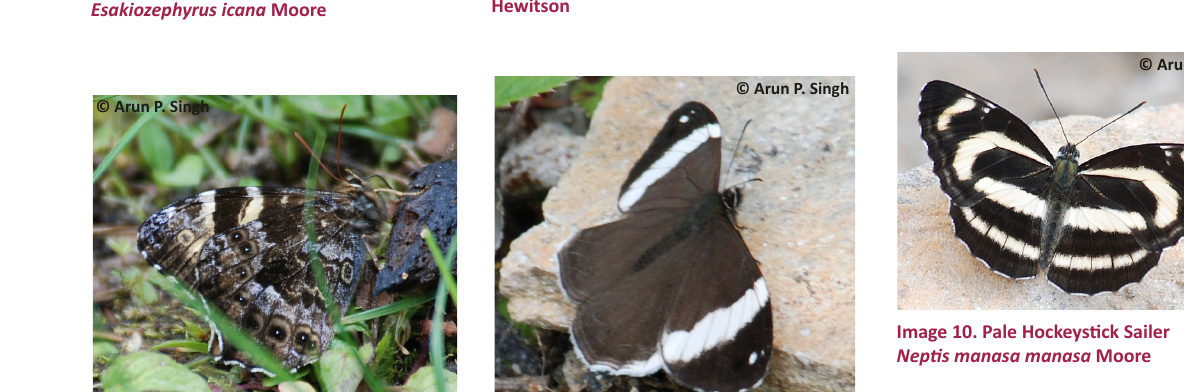
Image 6. Yellow Woodbrown Lethe